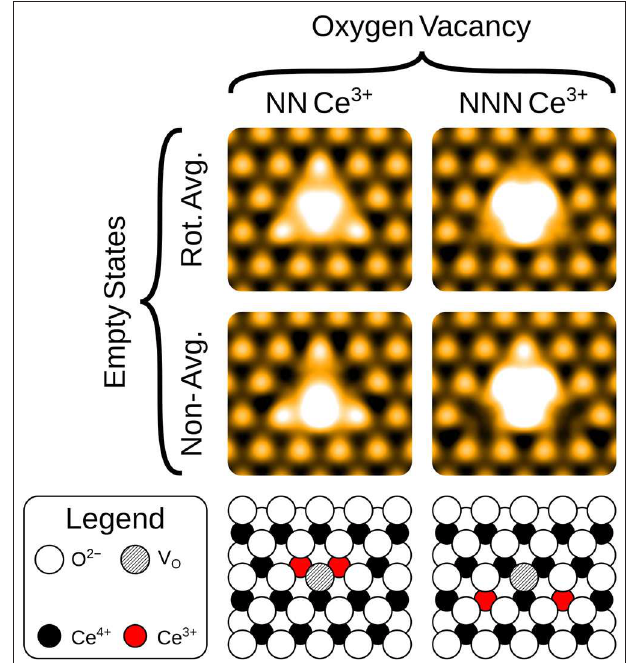
FIGURE 4 | Simulated empty images at a bias voltage of 2.0 eV of a surface OV, with the associated Ce 3 + ions at either nearest neighbor (NN) or next nearest neighbor (NNN) lattice sites. The precise locations of the Ce 3 + ions are shown in the schematics, for comparison with the non-rotationally averaged